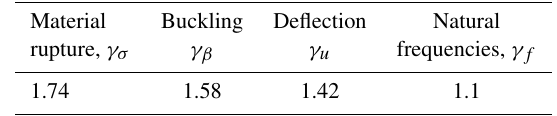
Table 3. Utilized factors of safety.